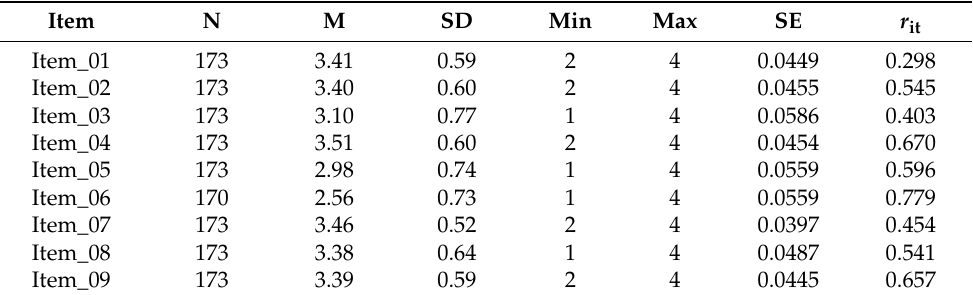
Table A4. Item and scale properties of the measurements for teachers’ perception of student-teacher relationship ( α =